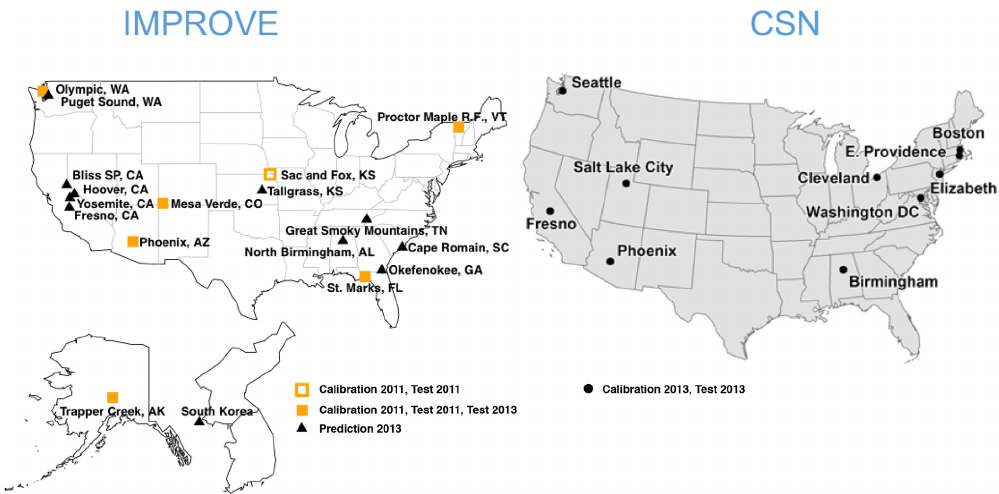
Figure 1. Map of IMPROVE and CSN sites used for this work. The Sac and Fox, KS, IMPROVE site was only operational for the first half of 2011. Samples from Fresno, CA, and South Korea were additionally used for a separate